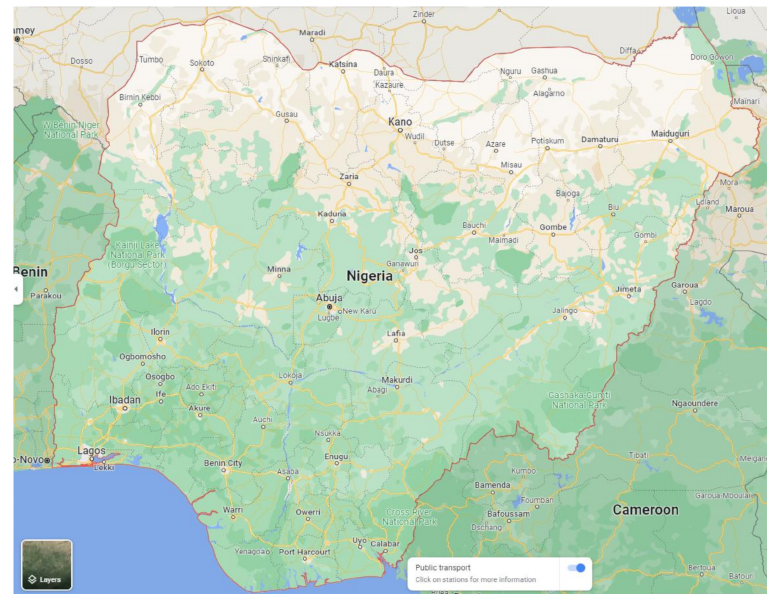
Figure 6. Map of Nigeria (plan view). Source: